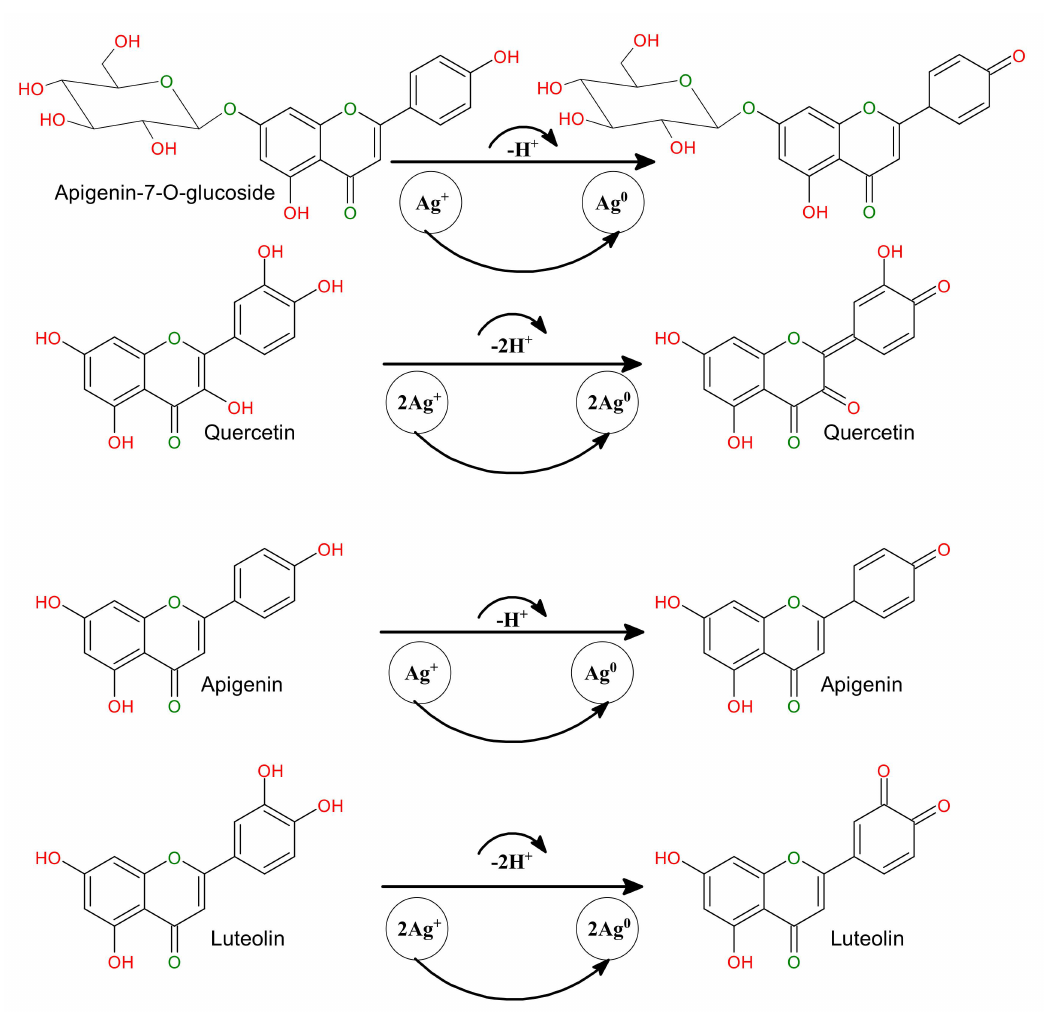
Figure 5. A plausible mechanism for the green synthesis of biomolecule-capped